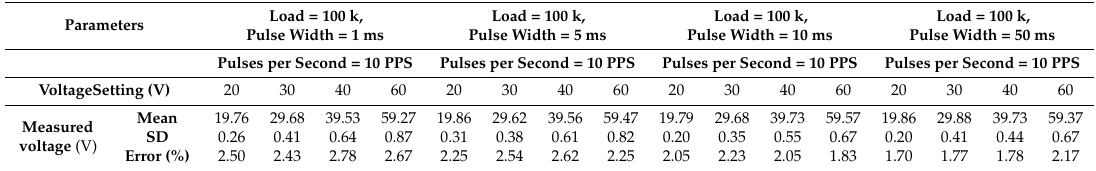
Table 1. Error estimation of the electroporation on generating electric pulses with specific pulse voltage. Parameters